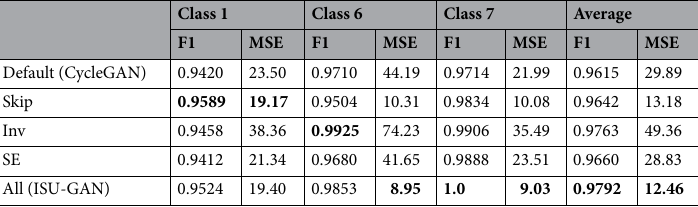
Table 3. Comparing the performance of different modules in different classes. Significant values are in